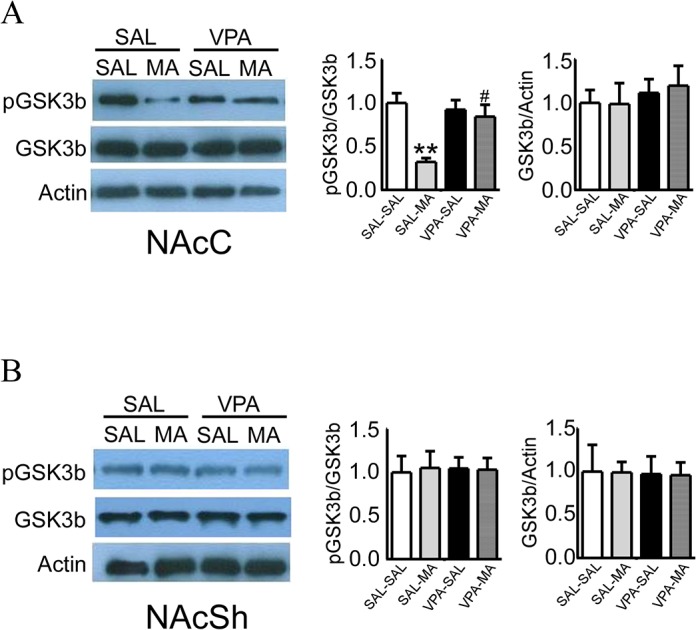
Effect of pre-treatment with VPA on MA-induced activation of GSK3β signaling in NAcC and NAcSh.Representative blots and summary histograms of phospho-GSK3β at Ser 9 (pGSK3b) and total GSK3β (GSK3b) from NAcC (A) and NAcSh (B) tissues from repeated saline (SAL) and VPA pre-treatment rats which then received SAL or MA injection. SAL-SAL group levels were set at 1 for quantifications. Data were expressed as mean ± SEM, n = 8 per group, ** p < 0.01 versus SAL-SAL, #
p < 0.05 versus SAL-MA, one-way ANOVA followed by Bonferroni's Multiple Comparison Test.